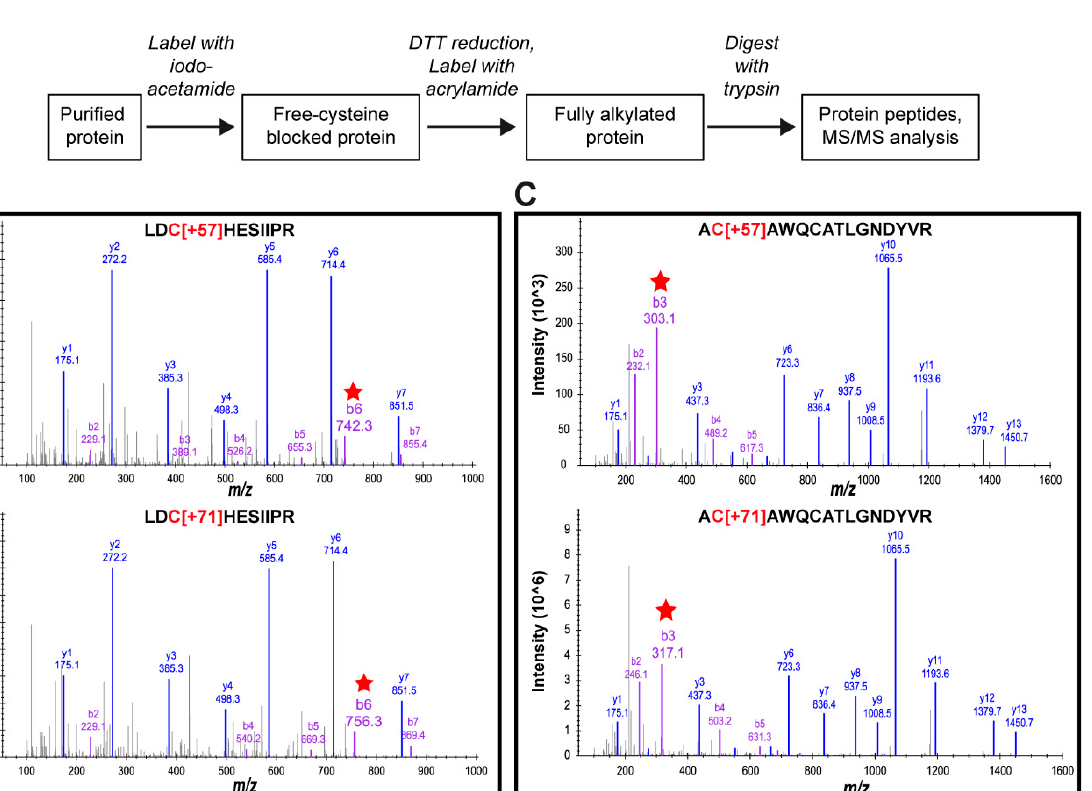
Figure 6. MS/MS spectra of peptide adducts obtained by a tryptic digest of Pdr11p. ( A ) Experimental flow chart for the chemical modification strategy and subsequent mass spectrometry-based identification of alkylated protein adducts. ( B – E ) Four cysteines ( B , C582; C , C603; D , C1290; E , C1306) were identified with two kinds of adducts, indicating their poten- tial involvement in disulfide bonds. Red arrows indicate the representative product ions with 14-Da mass differences by comparing the upper and lower spectra of each peptide.